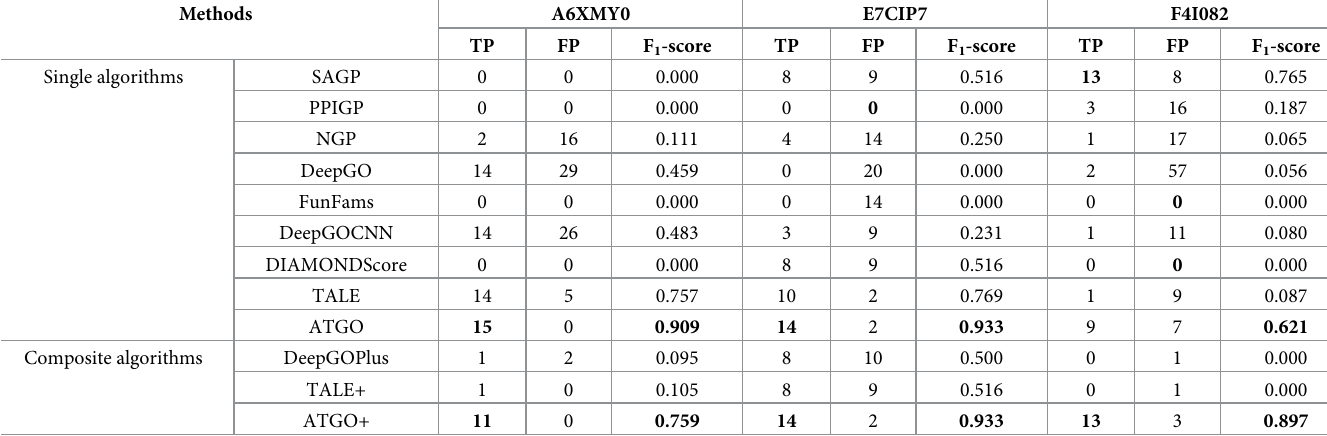
Table 3. The modeling results of the ATGO/ATGO+ in control with other 10 competing GO prediction methods on three representative examples in biological pro- cess (BP) prediction, where bold fonts highlight the best performer in each category. Methods Single